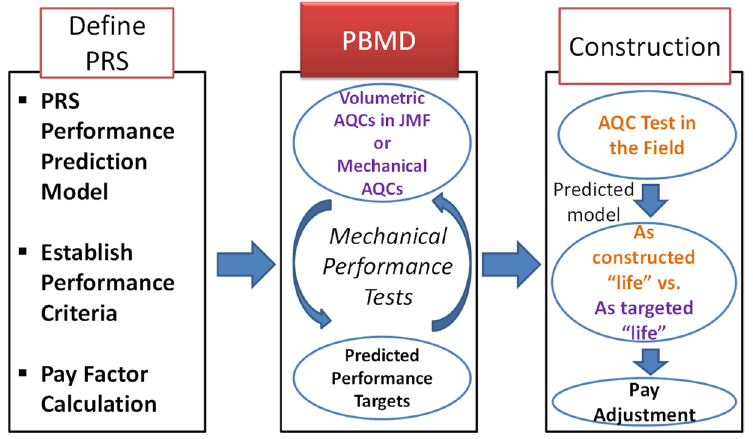
Figure 1. Role of performance-based mix design under the performance-related speci fi cation system.